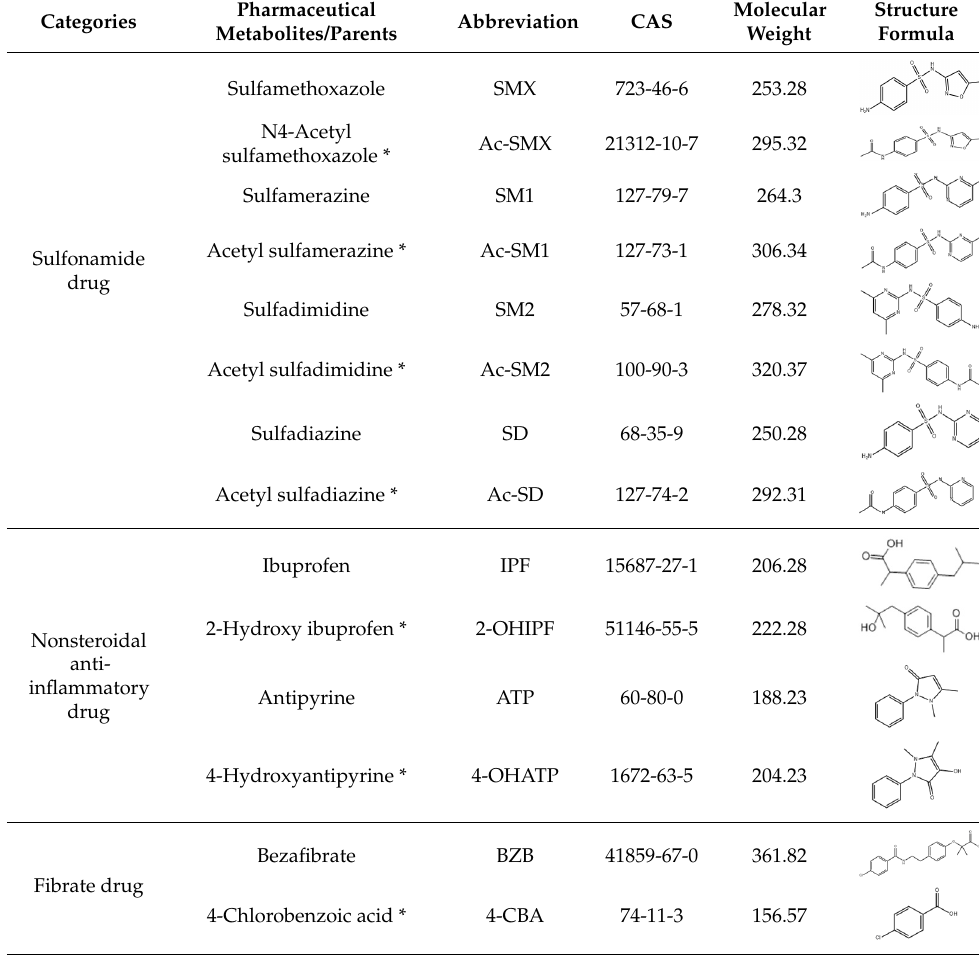
Table 1. The target pharmaceutical metabolites and their parents used in this study.